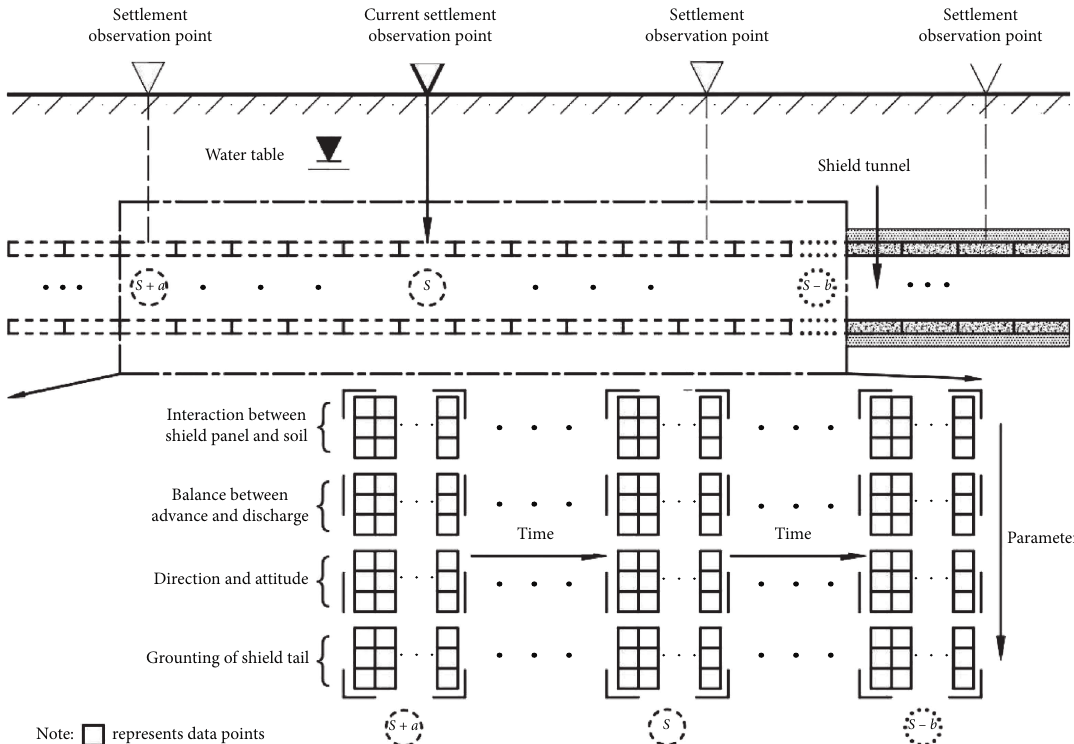
Figure 7: The MTS model for ground